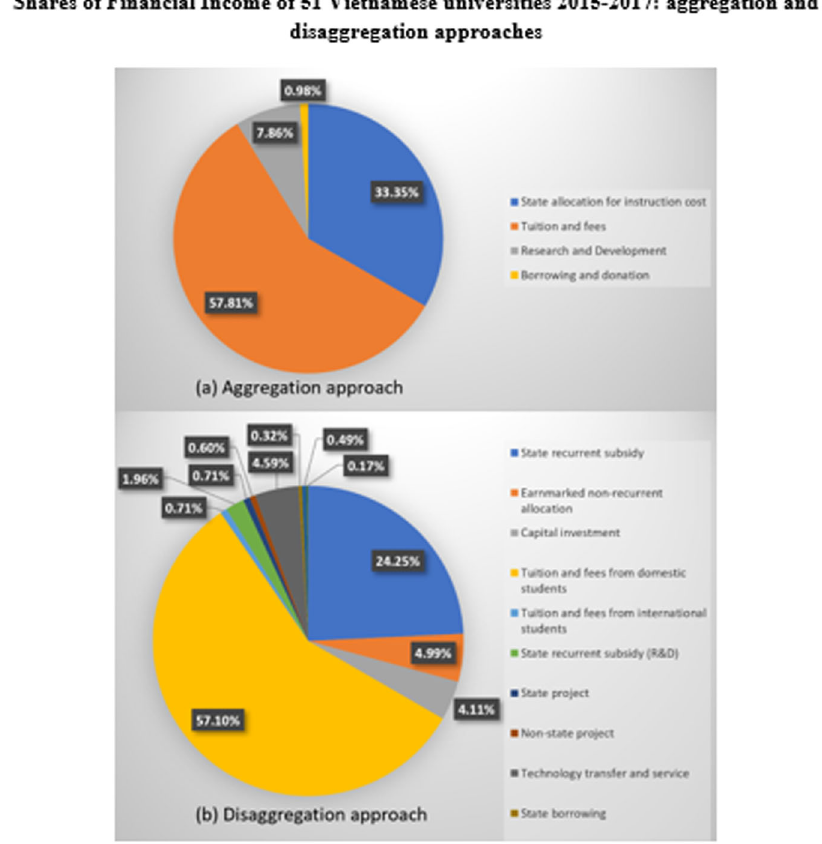
Fig. 2 Shares of fi nancial income of 51 Vietnamese universities 2015 – 2017: aggregation and disaggregation approaches.